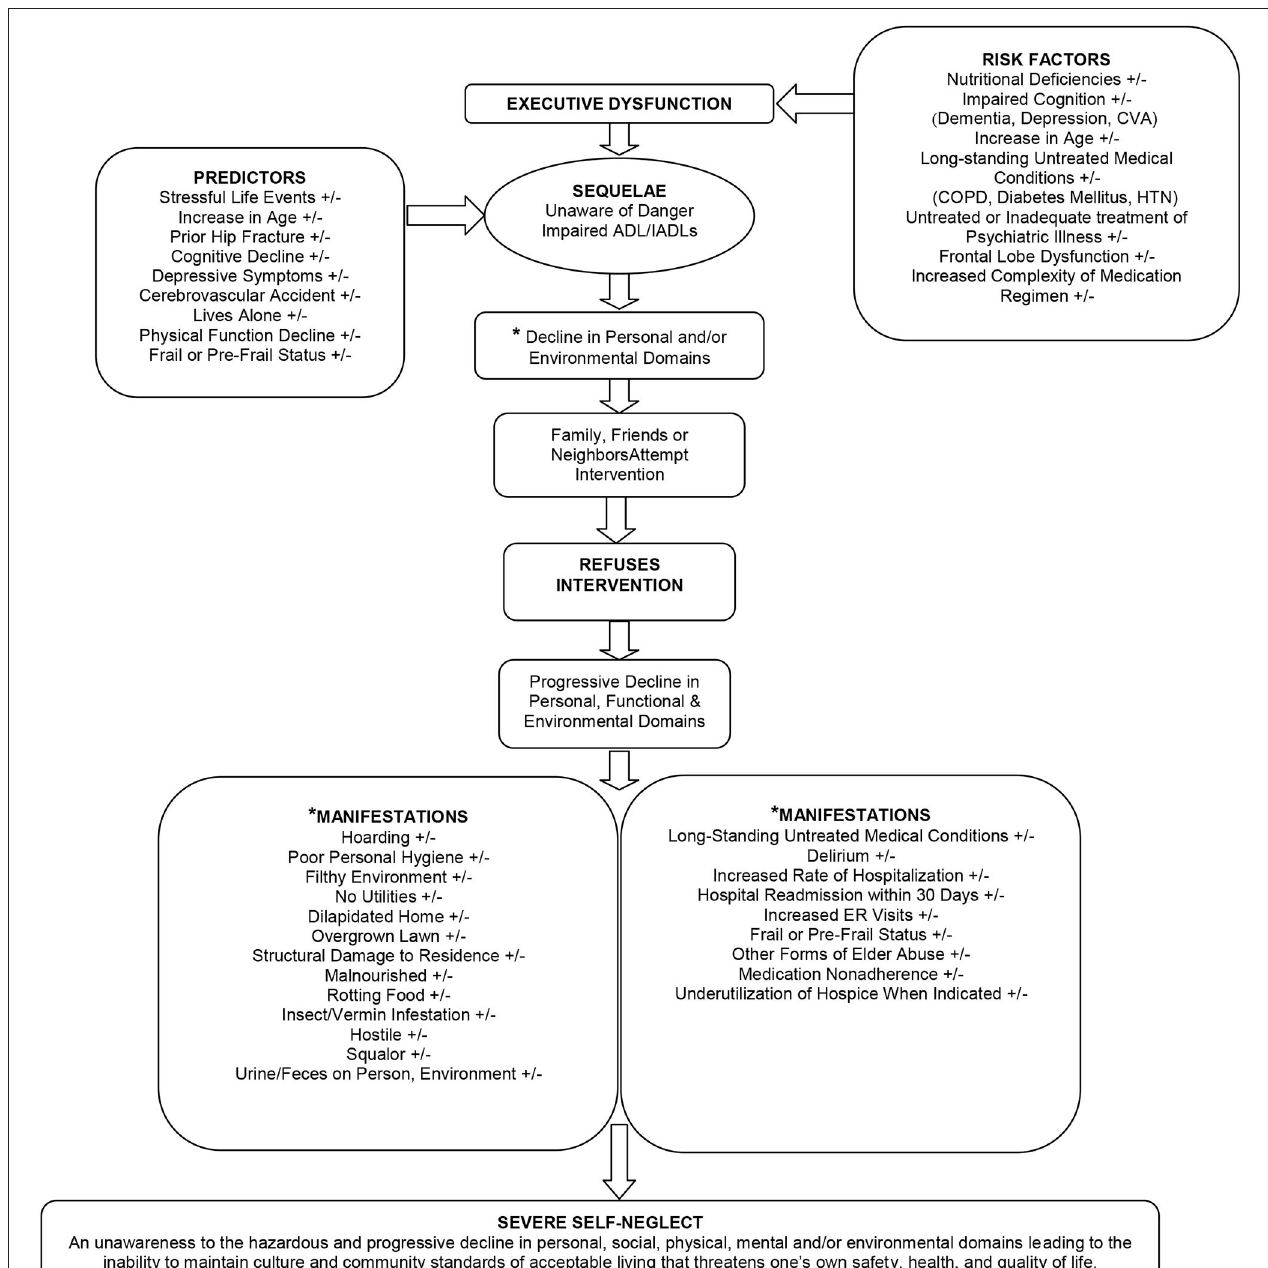
FIGURE 1 | Conceptual framework for the etiology of severe self-neglect by modification of the CREST model of